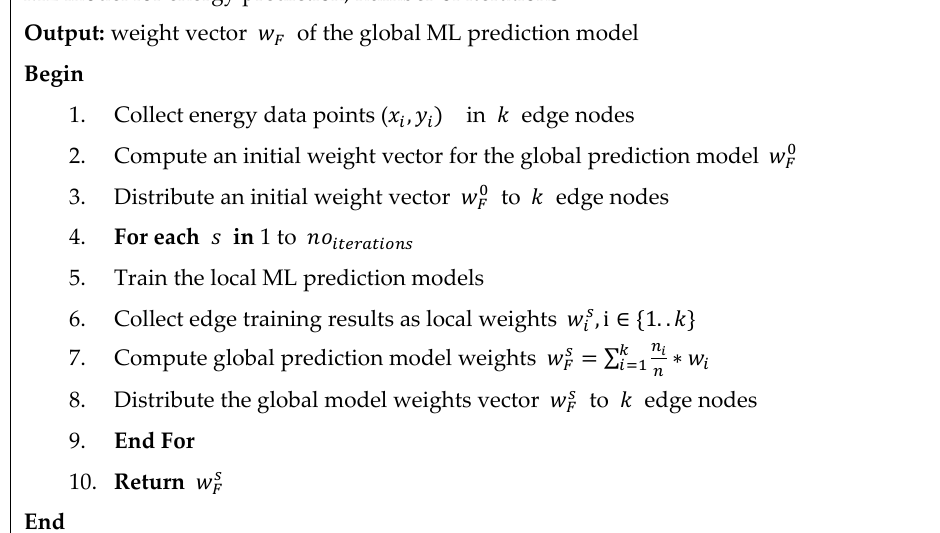
Figure 3. FL for prosumers energy prediction.